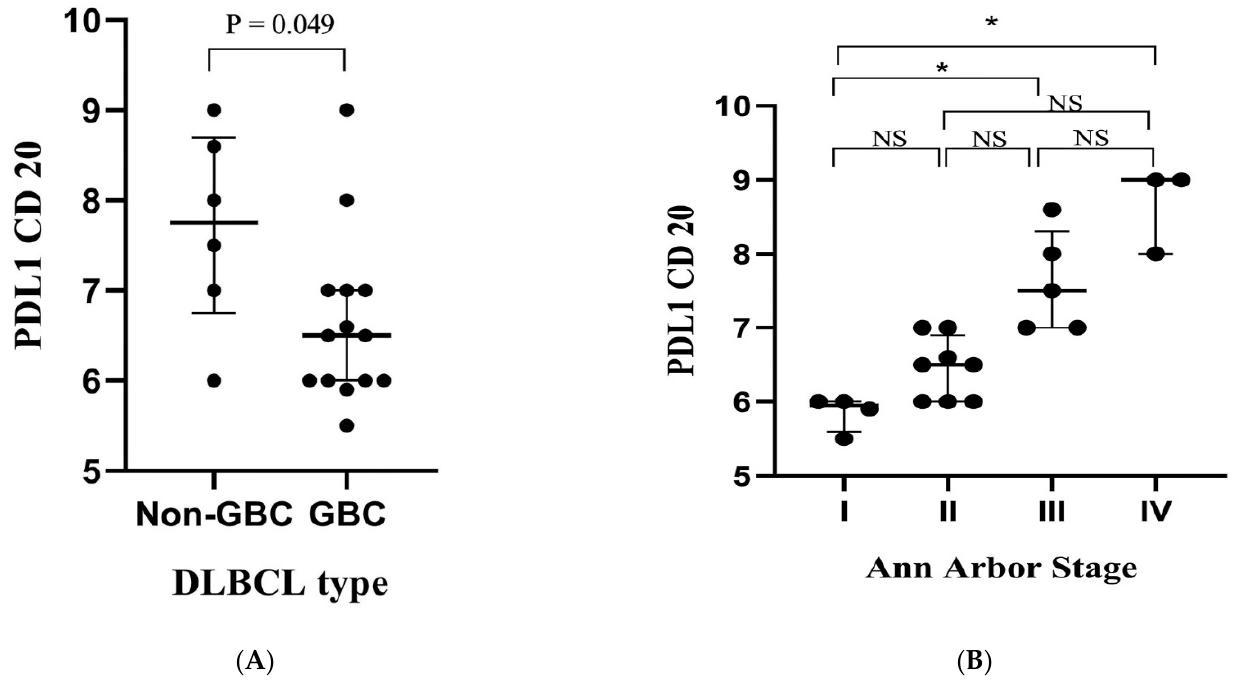
Figure 4. Percentage of PD-L1+CD20+ in post-therapy DLBCL patients. DLBCL type ( A ); Ann